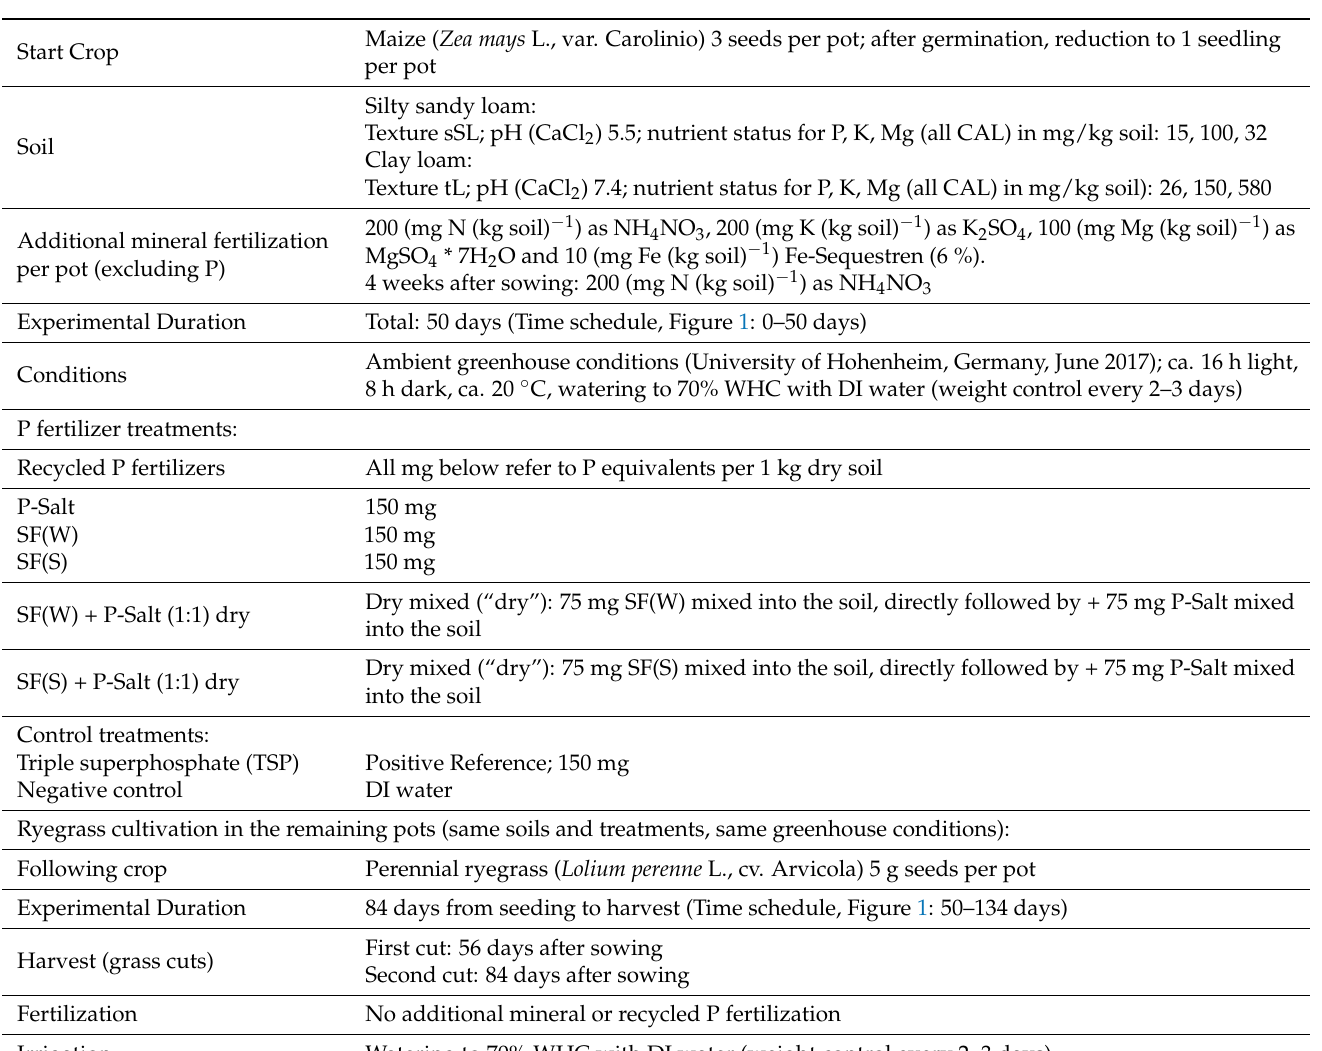
Table 1. Experimental setup of the greenhouse pot experiment with maize and